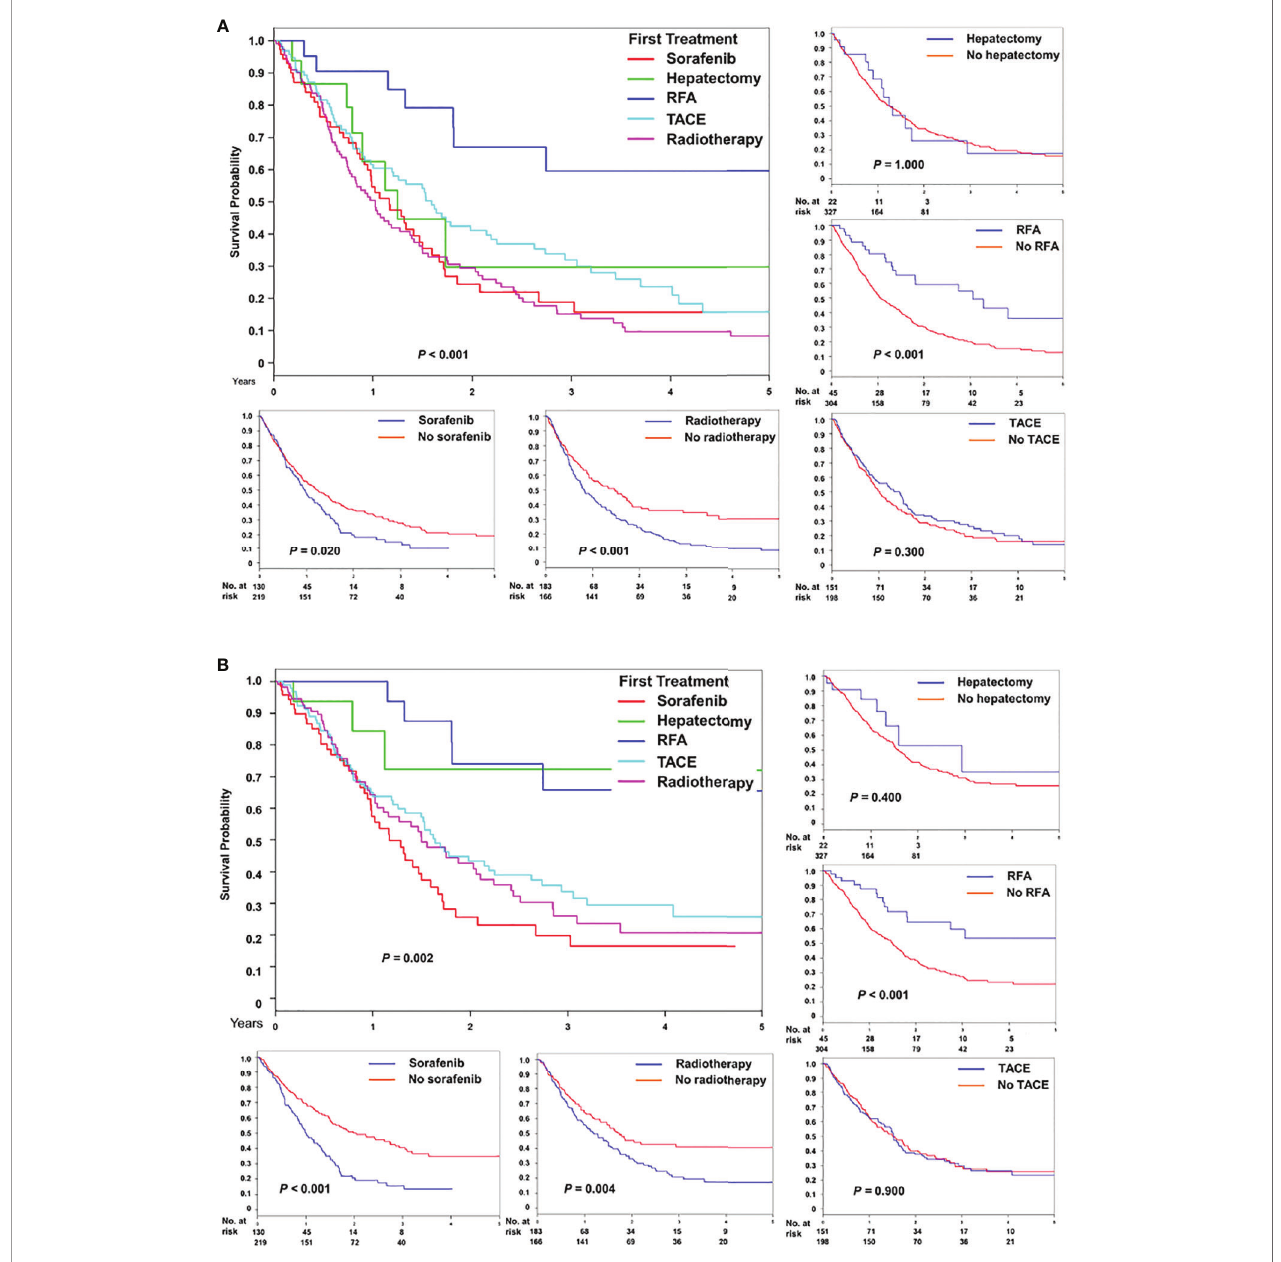
FIGURE 3 | Comparison of (A) overall and (B) HCC-speci fi c survival after treatment for recurrence, strati fi ed based on fi ve initial modalities, namely sorafenib, hepatectomy, radiofrequency ablation, transarterial chemoembolization, and radiotherapy, and individual